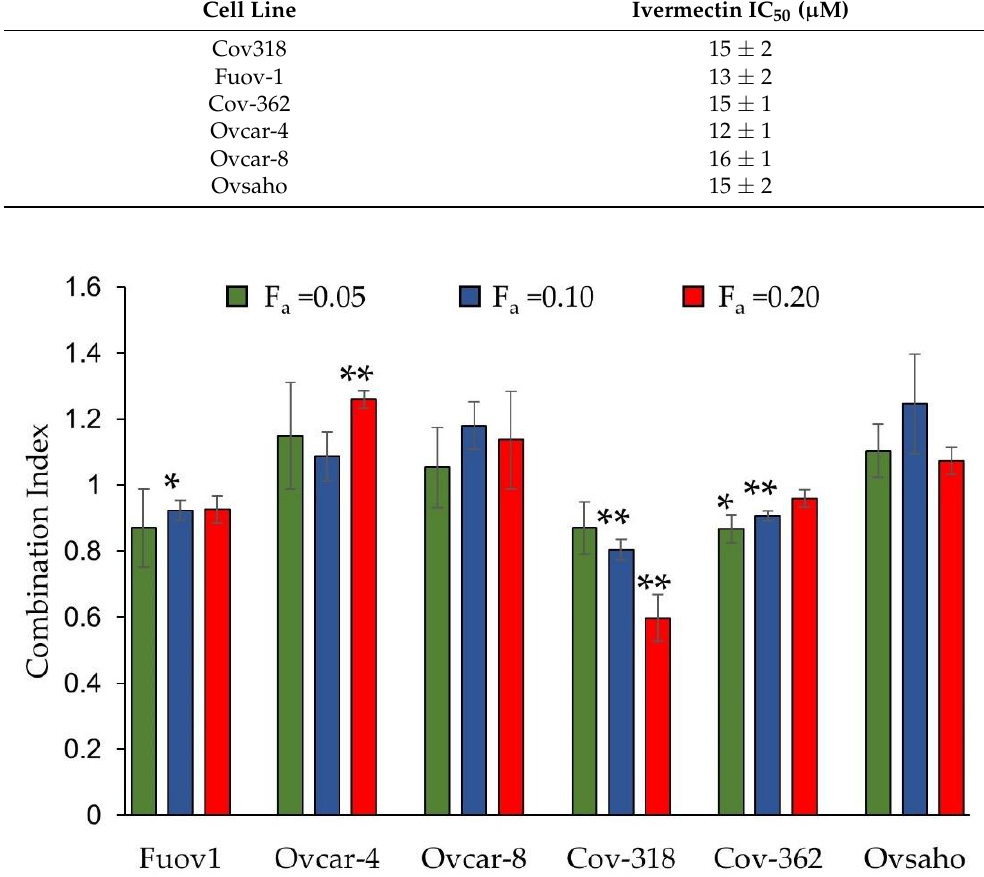
Table 1. Potency of ivermectin in cell growth assays with ovarian cancer cells. The cells were exposed to a range of concentrations of pitavastatin for 72 h and the relative number of surviving cells determined by staining with SRB. The IC 50 s of ivermectin are reported (mean ± S.D., n = 3). Cell Line Ivermectin IC 50 ( µ M) Cov318